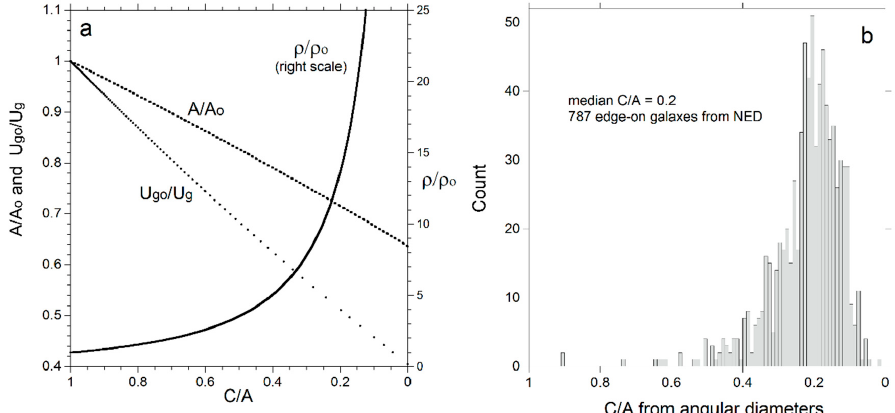
Figure 4. ( a ) Effect of vertical collapse on the characteristics of spinning oblate clouds. Ratios were obtained from Equation (14b). The trends for A / A o and U go / U g are nearly, but not precisely, linear on this graph. Please note that the x-axis is reversed, so progress is from left to right, as the nebula evolves into progressively denser, flatter shapes that have lower total energy. ( b ) Histogram of 787 edge-on galaxies from NED [42]. Note that the high abundance of galaxies at a c / a ratio of 0.2 corresponds to the sharp increase of density at similar c / a ratios in Figure 4a.